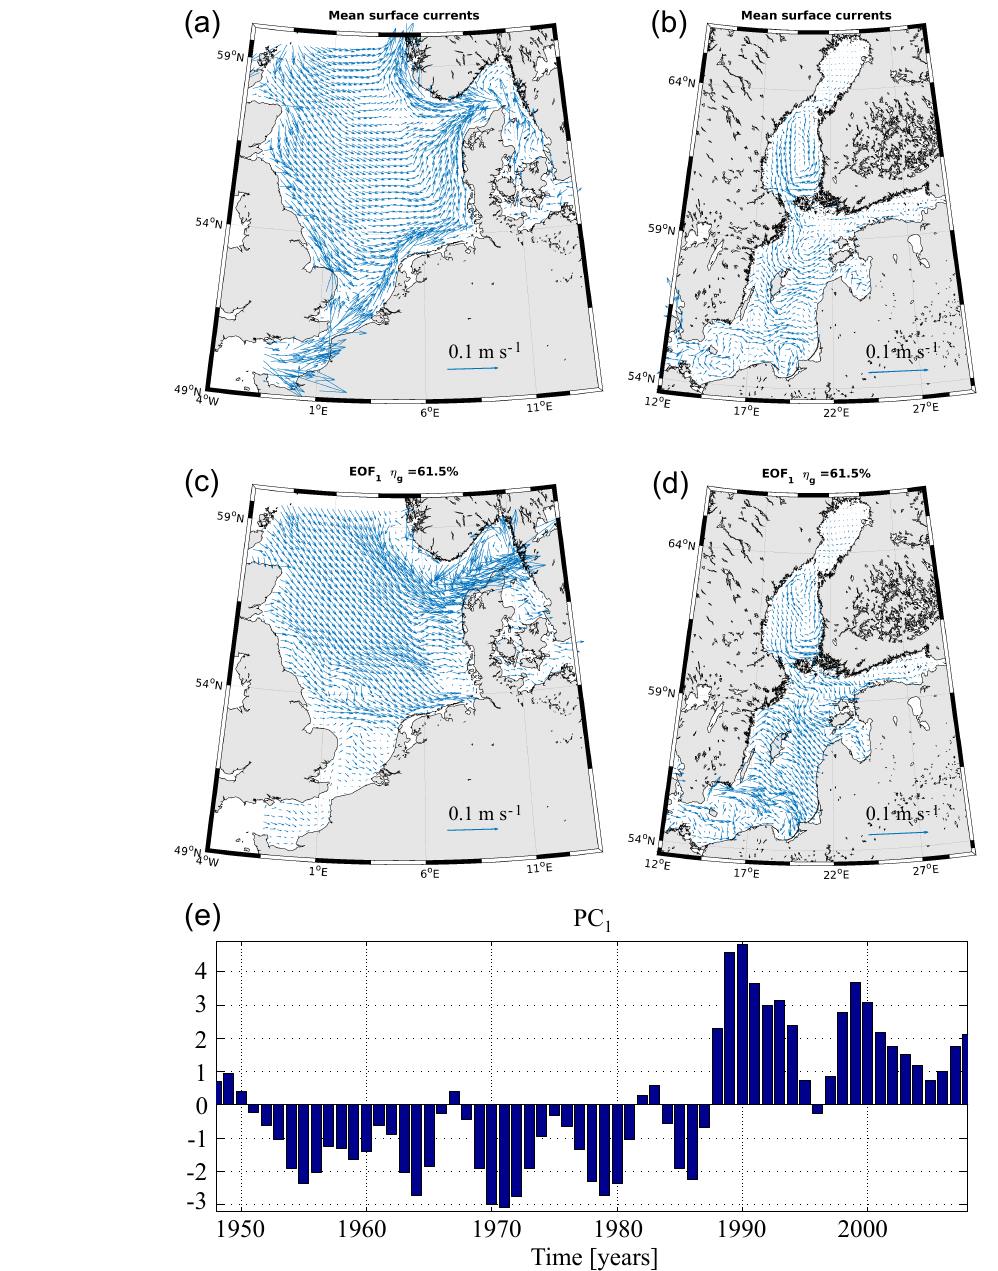
Figure 7. Mean surface current vectors in the North Sea (a) and Baltic Sea (b) ; EOF analysis of the anomalies in current vectors for the winter period January–March: current pattern for the first EOF (c, d) and first principal component (e)